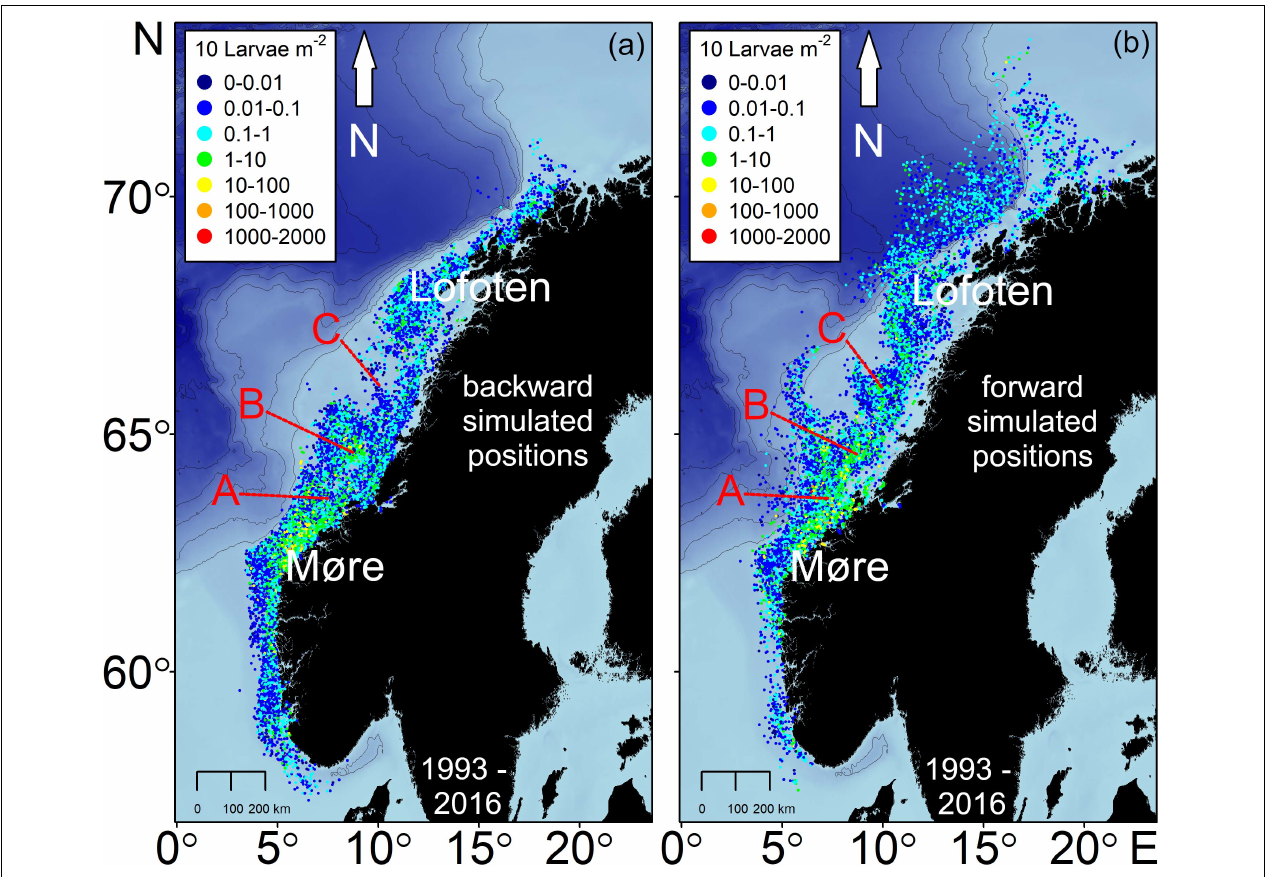
FIGURE 2 | Larval drift simulation from all survey stations of NSS herring larvae in 1993–2016; each point represents the abundances of every size class [per mm] collected during the surveys for (a) the backward simulated starting point and (b) the endpoint after maximum of 60 days of forward drift simulation. A = Frøya Bank, B = Halten Bank, and C = Træna